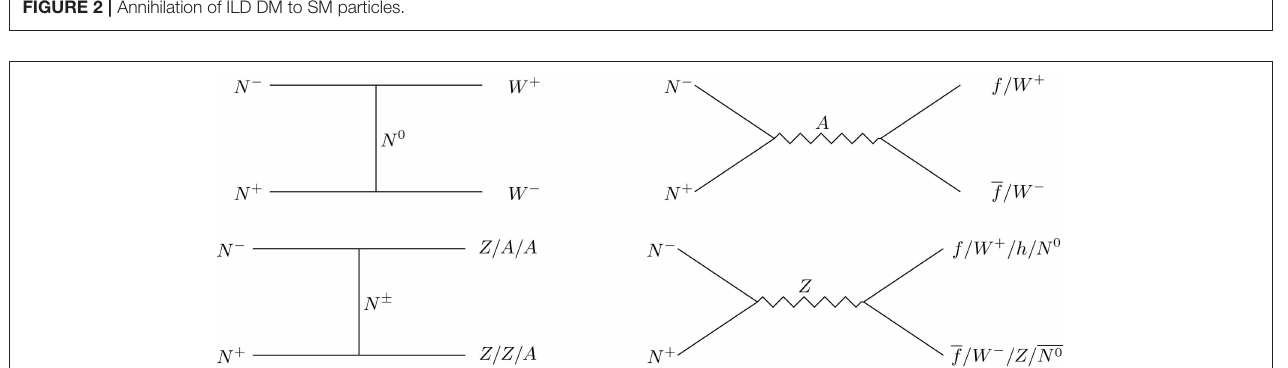
FIGURE 2 | Annihilation of ILD DM to SM particles.